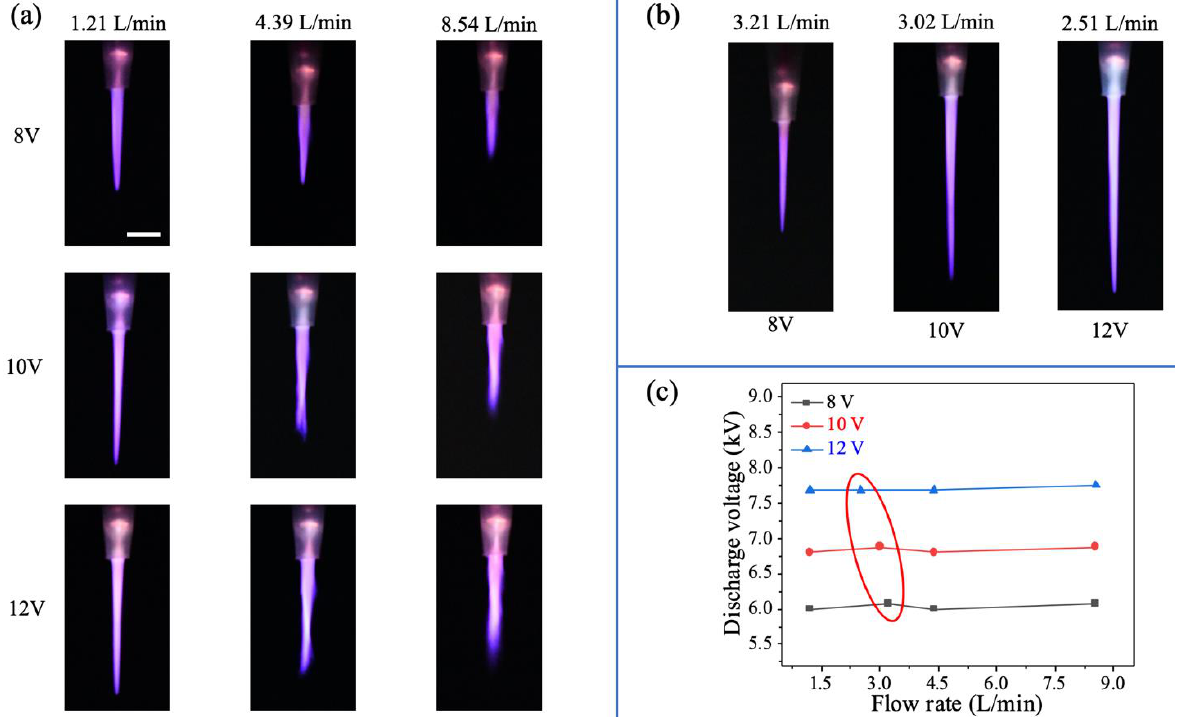
Figure 3. ( a ) The effect of flow rate (1.21 L/min, 4.39 L/min, and 8.54 L/min) and input voltage (8 V, 10 V, and 12 V) on the length of the tiny plasma jet. ( b ) The longest tiny plasma jet for 8 V, 10 V, and 12 V input. ( c ) The peak-peak discharge voltage for the tiny plasma jet at a different He flow rate. Scale bar: 5 mm.